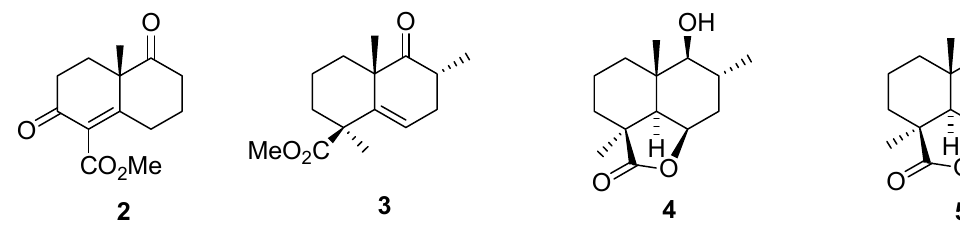
Figure 1. Synthesis intermediates of marrubiin (compounds 2 – 5 ).